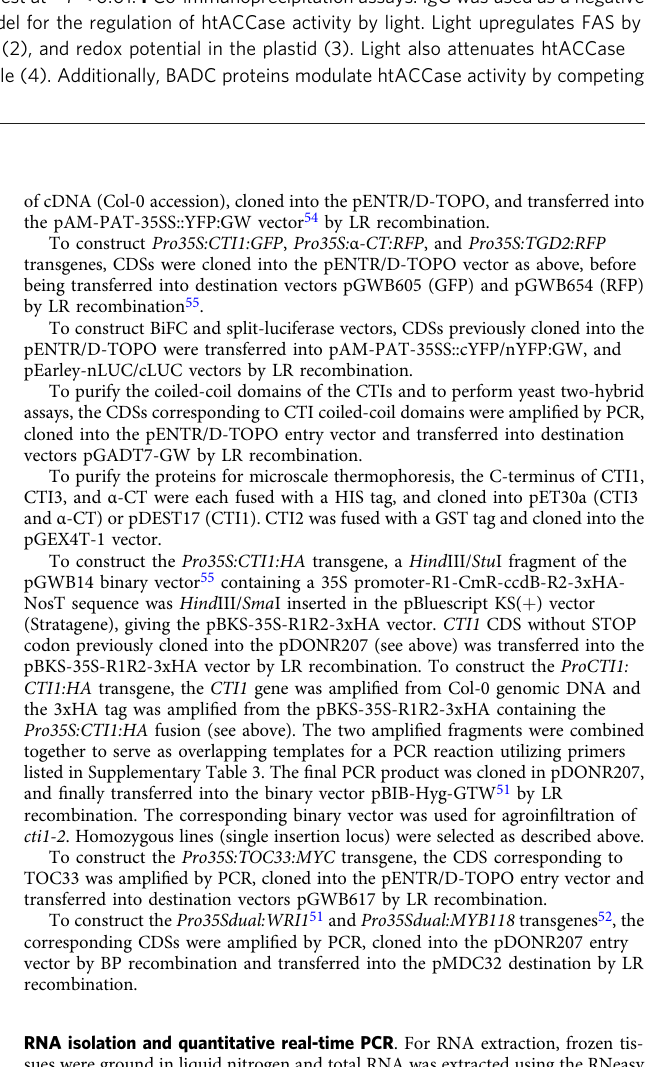
Fig. 5 CTIs interacting with α -CT regulate fatty acid synthesis in a light-dependent manner. a , b 14 C-acetate incorporation experiments carried out on rosette leaves aged 4 weeks and subjected to different light/dark regimes. Data are means ± SEM, n = 3 biologically independent plants. c Leaf total fatty acid content of rosette leaves from plants grown under different light regimes as determined by gas chromatography. Plants were grown in short-day (SD), long-day (LD) or constant light (CL) conditions for 4 weeks before analyses. Data are means± SEM, n = 4 biologically independent plants. Asterisks indicate signi fi cant difference from the wild-type control as determined by a two-tailed Student ’ s t -test at *** P < 0.001, ** P < 0.01, and * P < 0.05, respectively. d Split-luciferase assays. Three combinations of constructs were injected in leaves of Nicotiana benthamiana . After transformation, the plants were grown under different light/dark regimes before imaging of luminescence. Experiments were repeated three times with similar results. For each of the three independent transformations, three different leaves were observed. e Relative luminescence signal quanti fi ed after coexpression of CTI1-nLUC and α - CT-cLUC as displayed in d . Data are means ± SEM, n = 3 biologically independent plants. Asterisks indicate signi fi cant difference from the 2-d light/2d- dark treatment (before recovery) as determined by a two-tailed Student ’ s t -test at ** P < 0.01. f Co-immunoprecipitation assays. IgG was used as a negative control. Experiments were repeated three times with similar results. g Model for the regulation of htACCase activity by light. Light upregulates FAS